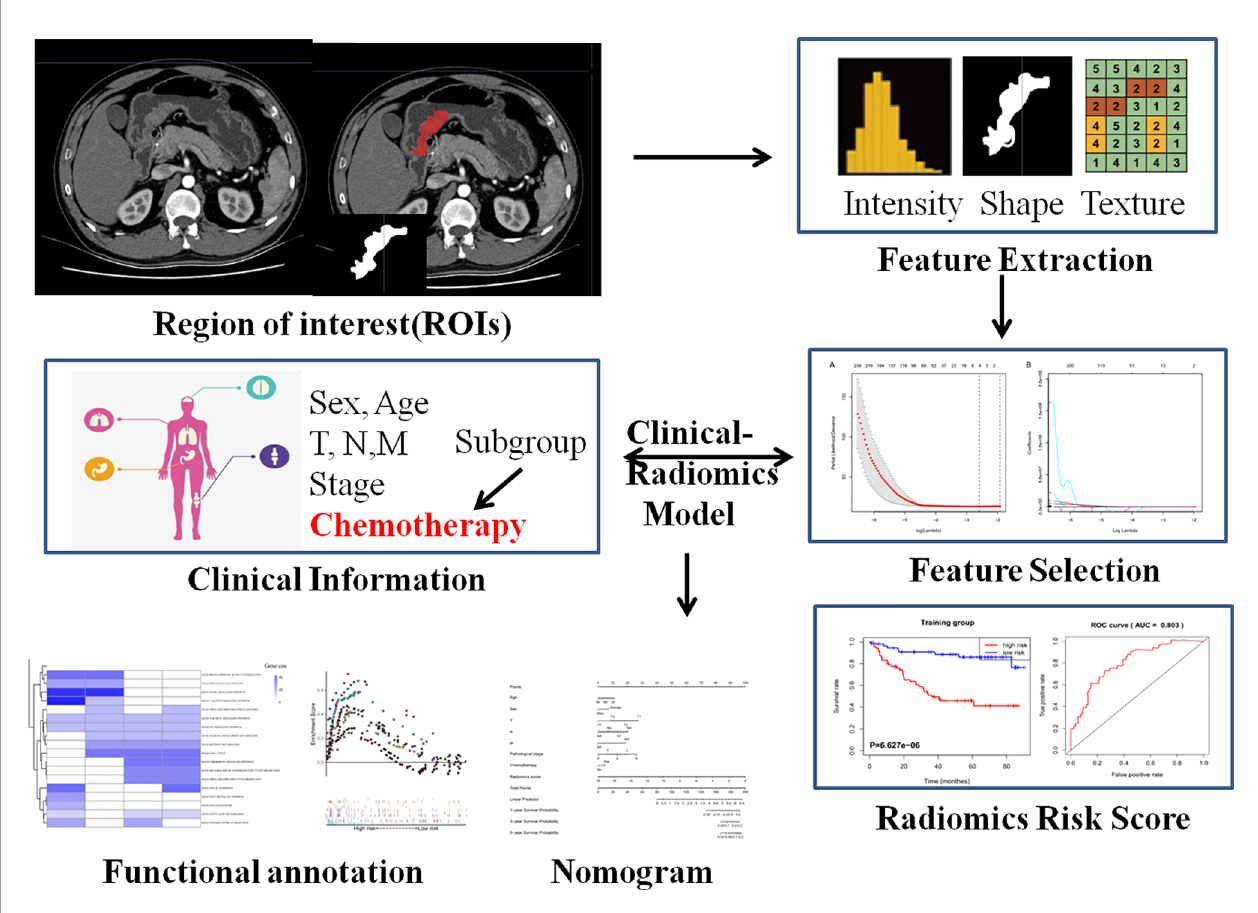
FIGURE 1 | Flowchart of the study design and main